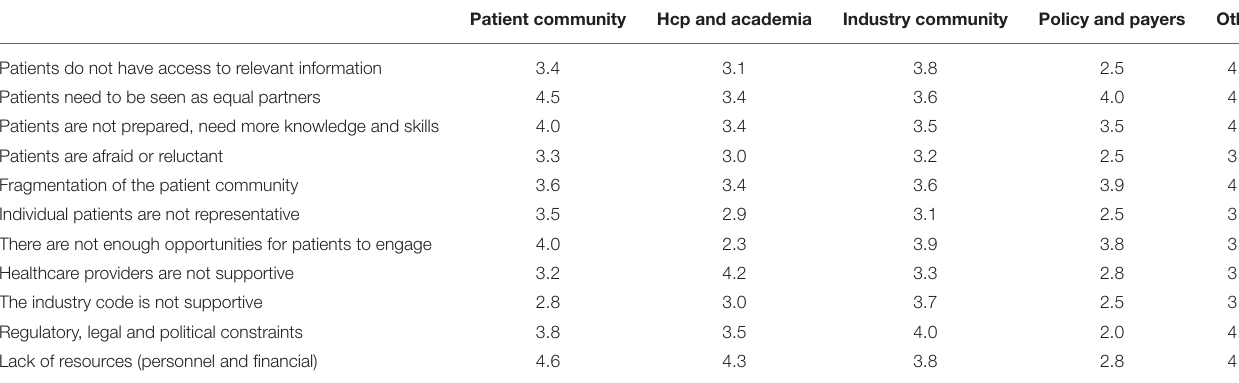
TABLE 3 | Barriers encountered per stakeholder.